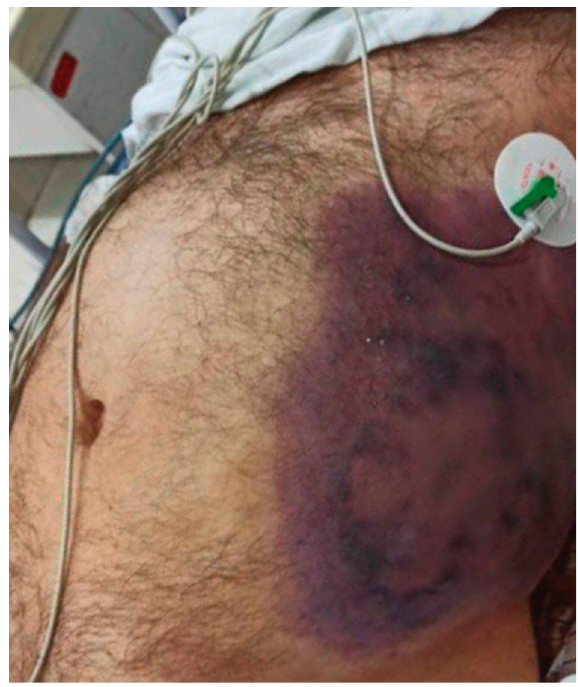
Figure 2: Ecchymosis in the left flank consistent with Grey Turner’s sign.